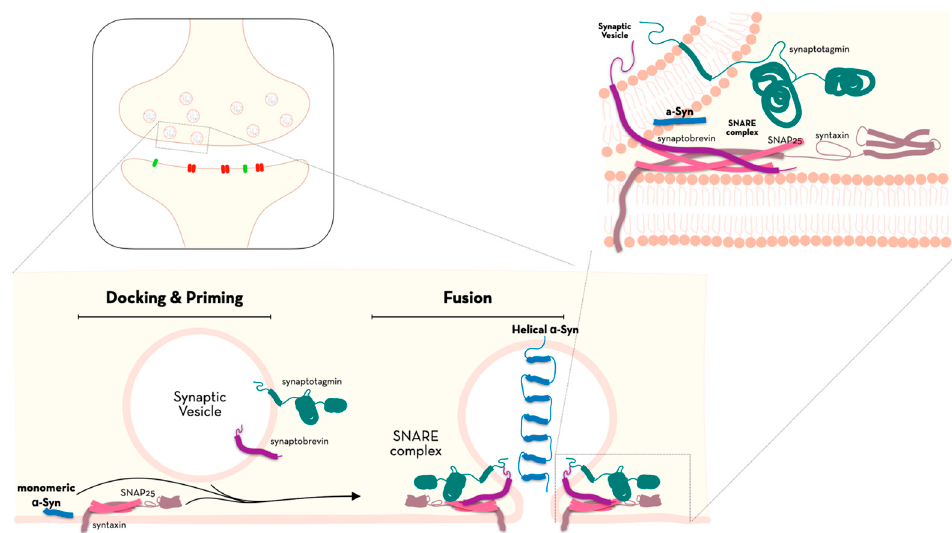
Figure 1. α -Syn’s role in vesicle priming, fusion, and dilation of exocytotic fusion pores and in the promotion of SNARE-complex assembly.